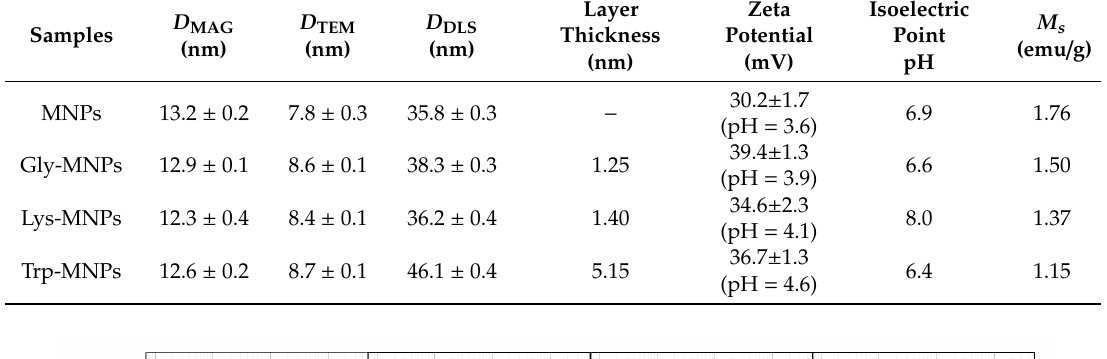
Table 2. Physico-chemical properties of MNPs and AA–MNPs obtained by different techniques. *The pH at which the zeta potential value has been determined.